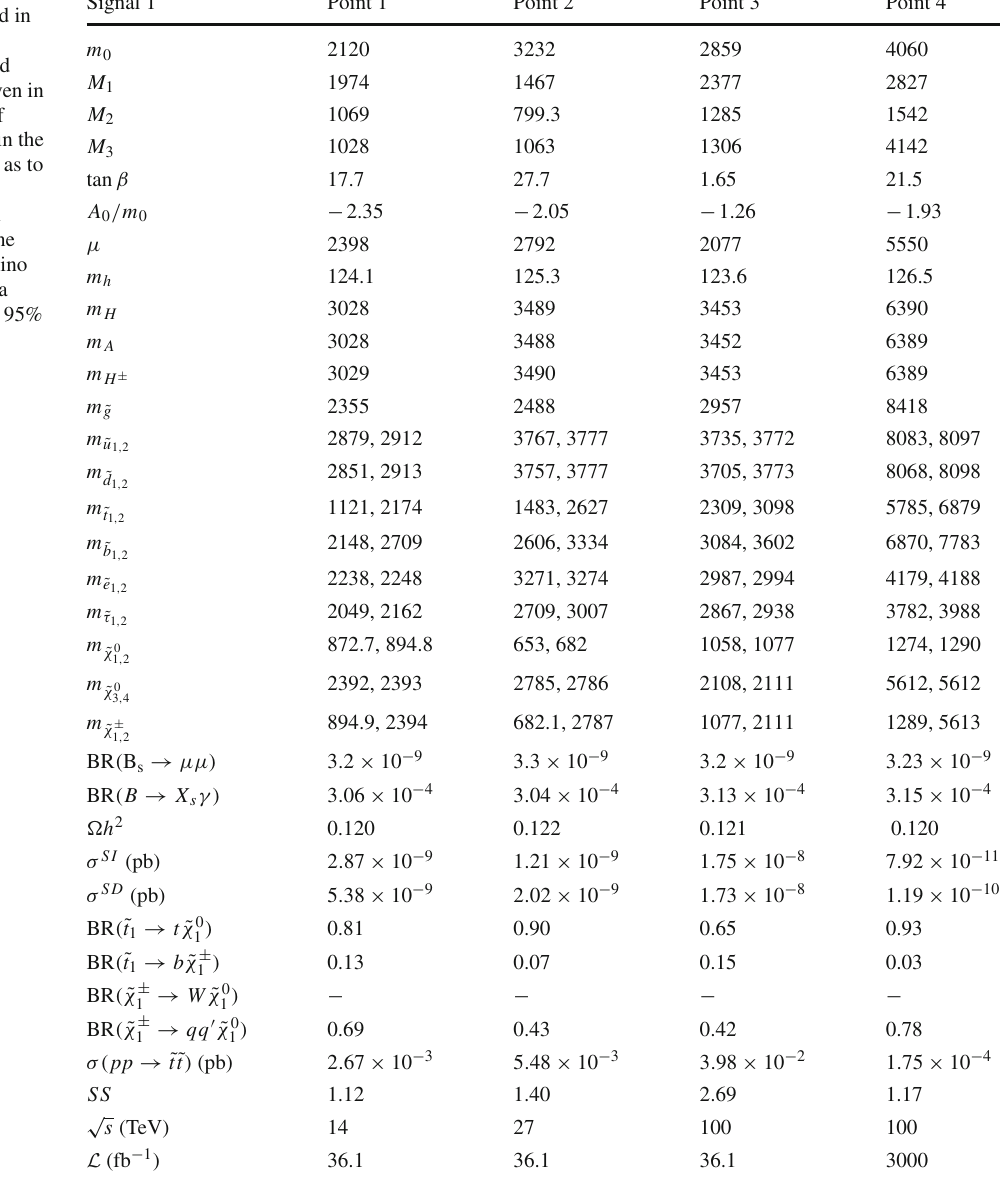
Table 1 Benchmark points for